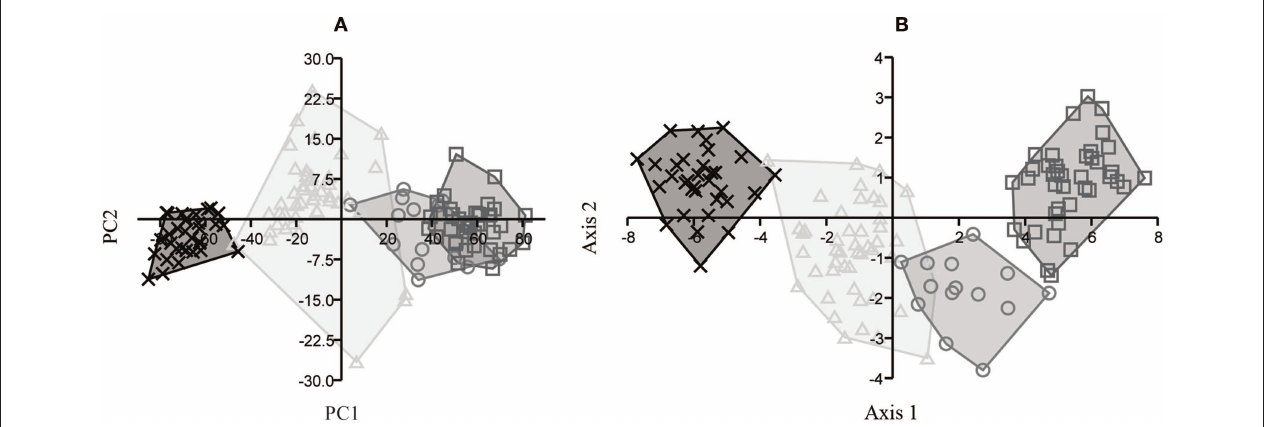
FIGURE 8 | MCIII analysis for E. andium (x), E. insulatus (triangle), E. neogeus (circle), and E. occidentalis (box): (A) projected scores from PCA, PC1 (96%) and PC2 (1%); (B) dispersal graph from CVA, axis 1 (91%) and axis 2